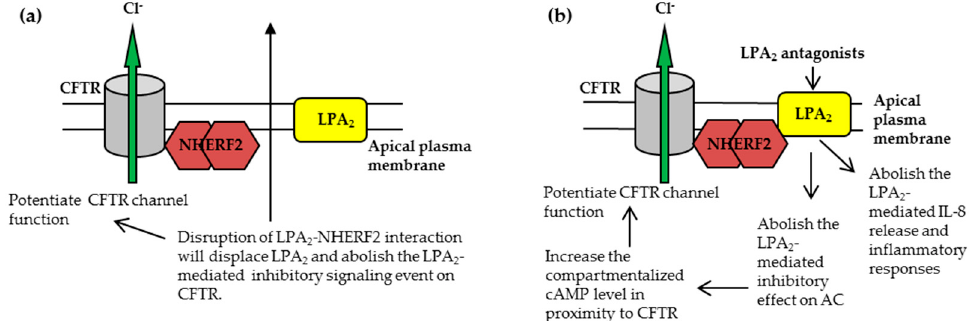
Figure 3. The CFTR-NHERF2-LPA 2 complex could be targeted to attenuate the LPA 2 -mediated inhibitory signaling on CFTR channel function and/or suppress the LPA 2 -mediated IL-8 release from airway epithelial cells. These two effects are beneficial to CF therapy. ( a ) The approach to disruption of NHERF2-LPA 2 interaction; ( b ) The approach to antagonism of LPA 2 .